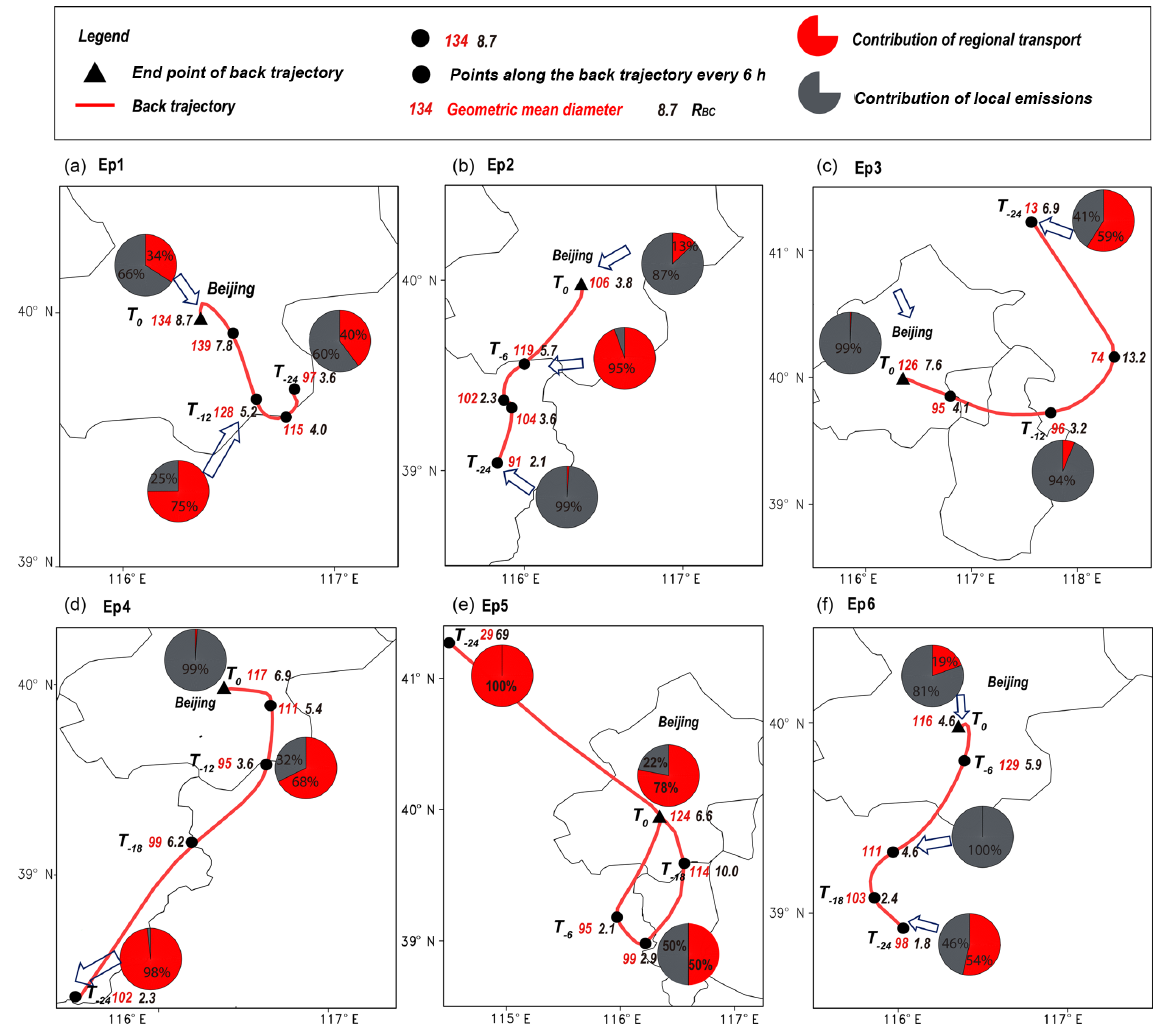
Figure 12. Variation of aerosol properties along transport pathways. Panels (a–f) refer to Ep1–Ep6. The red lines refer to 24h backward trajectories at an altitude of 100m. Aerosol properties include the geometric mean diameter (GMD; in nanometers – the red numbers beside the solid blocks), the mass ratio of the coating of BC to BC ( R BC ; an indicator of the degree of aging – represented by the black numbers beside the solid blocks), the regional sources of BC (shown by the pie charts – red represents regional transport and gray is the local contribution). Solid black triangles denote the end points of back trajectories, referred to as T 0 . Solid black circles denote points along trajectories per 6h. T − 6 , T − 12 , T − 18 , and T − 24 denote 6, 12, 18, and 24h before arriving at the end point. End times of back trajectories